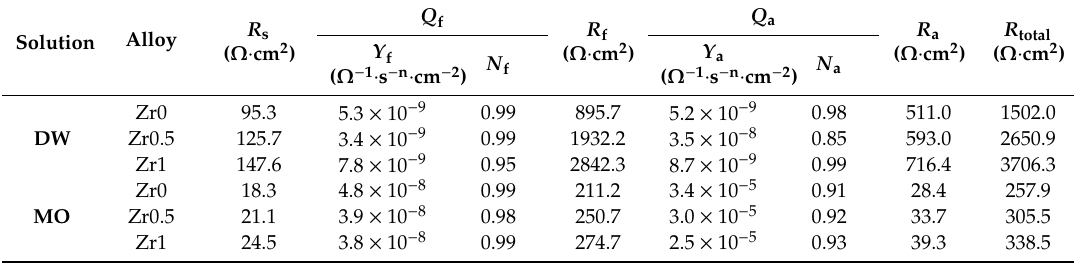
Figure 5. Polarization curves of the as-spun Zr0, Zr0.5 and Zr1 ribbons in ( a ) DW and ( b ) MB solution ( T = 298 K, pH = 3, C H2O2 = 1 mM and C MB = 100 mg L − 1 ) and their Nyquist curves in ( c ) DW and ( d ) MB solution. The insets in ( c ) and ( d ): the general fitted circuit. Symbols show the experimental data while solid lines are fitting results. Table 2. Parameters from EIS measurements: R s , solution resistance; Q f and R f , resistance of passivation film; Q a and R a , resistance of electrochemical reaction; R total , total resistance. Solution Alloy Solution